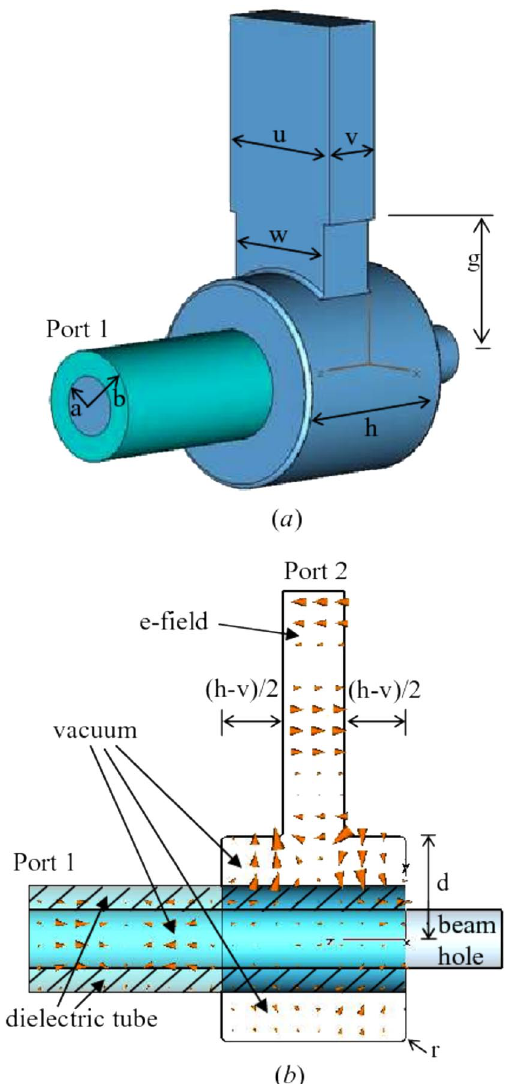
FIG. 6. (Color) CST geometry of the TM the background material set to the perfect electrical conductor boundary condition ( a (cid:3) 6 : 02 mm , b (cid:3) 11 : 17 mm , d (cid:3) 21 : 30 mm , g (cid:3) 32 : 43 mm , h (cid:3) 38 : 32 mm , r (cid:3) 1 : 00 mm , u (cid:3) 28 : 50 mm , v (cid:3) 12 : 62 mm , w (cid:3) 25 : 00 mm ). (a) Full view; (b) cutplane.